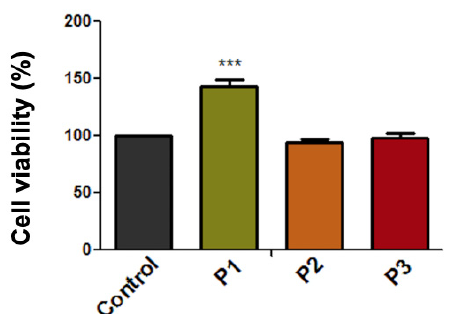
Figure 4. Cell viability percentage of primary human gingival fibroblasts (HGFs) cells at 24 h post-treatment with extraction medium of test orthodontic implants (P1, P2, P3). Data are presented as cell viability percentage (%) normalized to control cells. The results represent the mean values ± SD of three separate experiments. One-way analysis of variance (ANOVA) test was performed to determine the statistical differences followed by Tukey’s multiple comparisons analysis (*** p < 0.001).